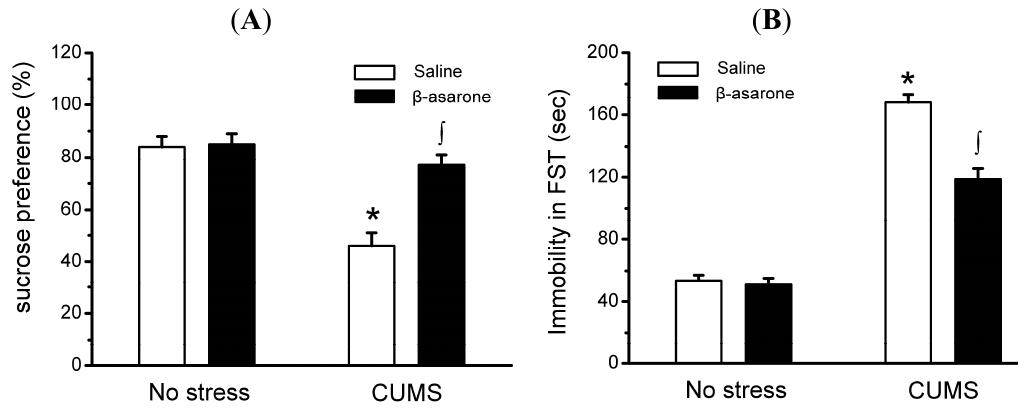
Figure 3. β -Asarone treatment promotes hippocampal neuronal neurogenesis in CUMS-exposed rats. Rats were orally treated with β -asarone (25 mg/kg per day) or saline for 28 days while being exposed to CUMS or control conditions. ( A ) Representative photomicrographs depicting the distribution of newly born cells ( i.e ., BrdU + cells) in the subgranular zone-granule cell layer of hippocampi from rats. ( B ) Histograms of the number of BrdU-positive cells in the subgranular zone-granule cell layer of hippocampi from rats. Data were presented as mean ± S.D., n = 6 per group. * , p < 0.05 compared with no stress/saline animals;  , p < 0.05 compared with CUMS/saline animals (analysis of variance and SNK post hoc